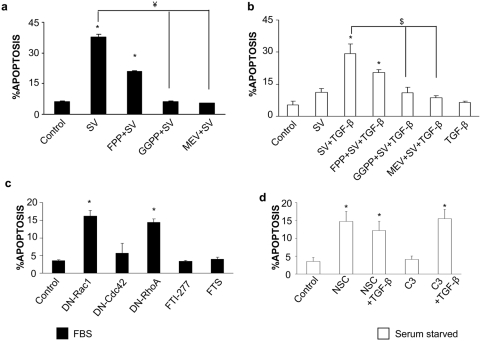
RhoA mediates Simvastatin/TGF-β-induced VSMC death.VSMCs were incubated in 10%FBS medium (black bars: a) or in serum-free conditions (white bars: b). Cells were treated with 10−4 mol/L Simvastatin (SV) alone or in combination with 1ng/mL TGF-β for 48h. Some cells were pretreated for 1h with 5 µg/mL GGPP, or FPP, or 10−4 mol/L mevalonate (MEV) before Simvastatin treatment. *p<0.05 vs. control. ¥ p<0.05 vs. 10−4 Mol/L SV. $ p<0.05 vs. 10−4 Mol/L SV+TGF-β c. Cells grown in 10%FBS were either treated with FTI-277, farnesylthiosalicylic acid (FTS), or transfected with a control, DN-Rac1, DN-Cdc42 or DN-RhoA expression vectors and apoptosis was assessed 48h later. *p<0.05 vs. control. d. Cells incubated in serum-free medium were treated with NSC-23766 (50mMol/L) or C3 exoenzyme (10 µg/mL) alone or in combination with 1ng/mL TGF-β for 48h. The graphs show the percentage of hypodiploidic cells measured by FACS and expressed as mean±SEM of 4 experiments. *p<0.05 vs. control.